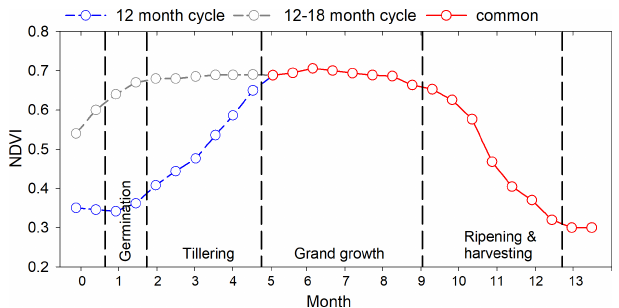
Figure 6. Growing stages of sugarcane and the respective NDVI changes. The grey and red symbols represent the NDVI curve for the planted sugarcane with a 12–18-month cycle, and the blue and red symbols represent the NDVI curve for the ratoon sugarcane with a 12-month cycle. The growing stages of the 12-month cycle sug- arcane (germination, tillering, grand growth, and ripening) are la- belled in the